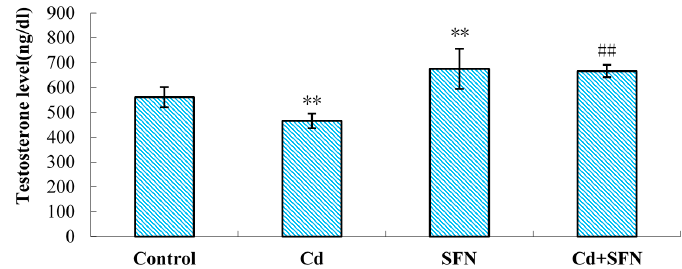
Figure 2. Serum testosterone levels. Values represent mean ± SEM in each group of 10 mice. ** p < 0.01 vs. controls; ## p < 0.01 vs. cadmium group.